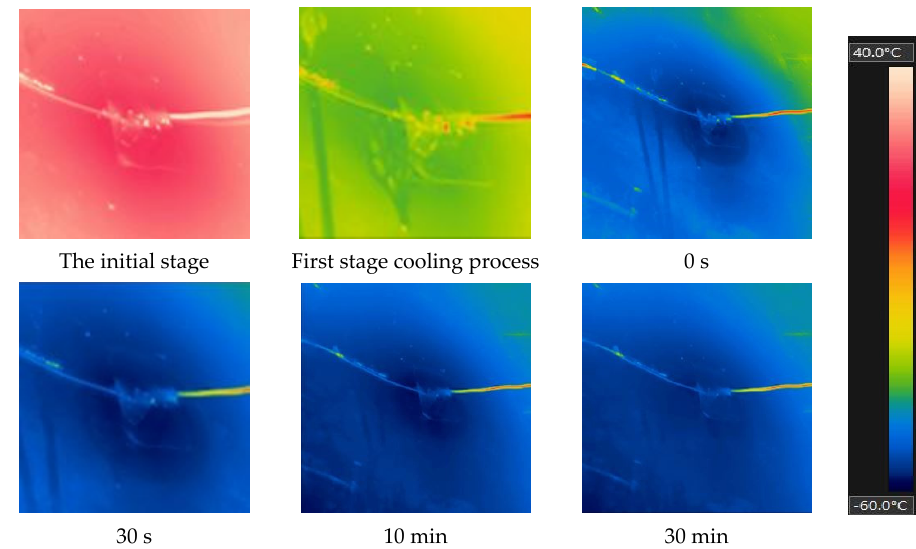
Figure 11. Infrared image change curve over time.